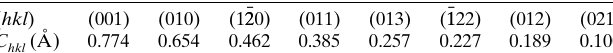
Table 8 Magnitudes of C hkl in AlN [wurzite structural type, space group type P 6 3 mc , the structure is reported by Xu & Ching